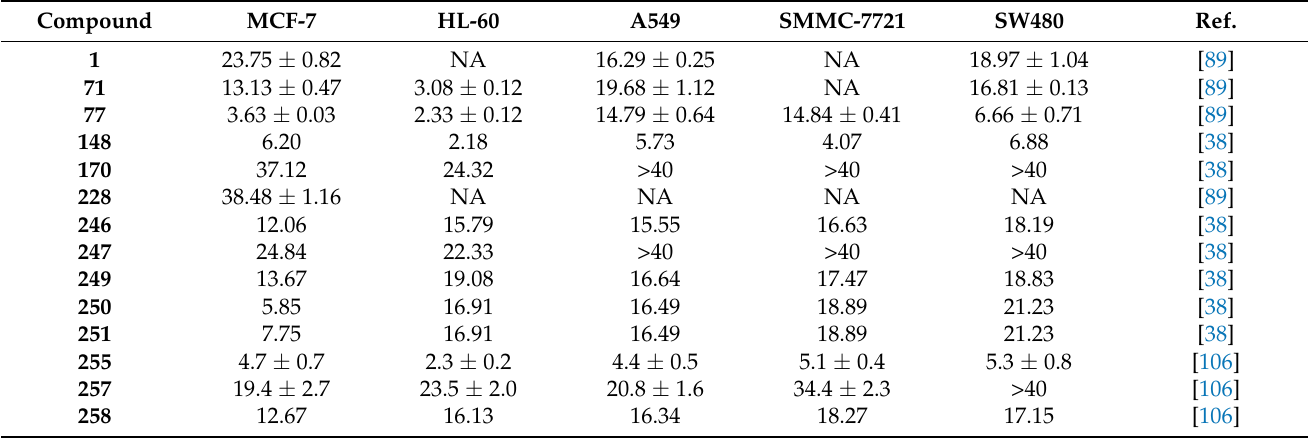
Table 6. The antiproliferative activity of the stilbenes against five cancer cells (IC 50 µ